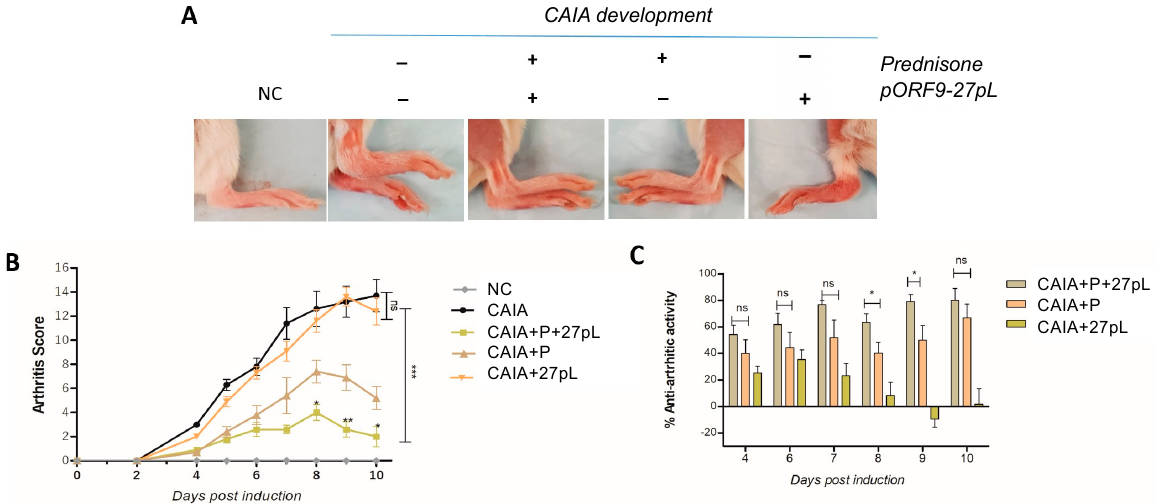
Figure 2. Modulation of arthritis severity by monotherapies or dual therapy of prednisone (P) and pORF9-IL27pL (27pL). ( A ) Morphological changes of digits, foot, and ankle edema in collagen antibody-induced arthritis (CAIA) mice with and without treatments and NC (no CAIA control). ( B ) Arthritis score showed an increase in the CAIA animals indicating the onset of RA. Treatment of the CAIA mice with P significantly reduced the arthritis score indicating a reduction in arthritis severity. Combination with pORF9-IL27pL (27pL) significantly improves P’s effect on day 8, 9, and 10 post-induction. 27pL treatment by itself was not able to prevent the onset of RA. ( C ) Anti-arthritic activity analysis showed efficacy for P monotherapy and P + 27pL combination on day 8 and 9. Results represent mean ± SEM. This figure is the combination of two independent experiments ( n = 11–12). A one-way analysis of variance (ANOVA) followed by Tukey’s multiple comparison t -test was used to calculate the statistical difference. The Mann–Whitney non-parametric test was used to calculate the statistical difference between P and P + 27pL (* p ≤ 0.05; ** p ≤ 0.01, *** p ≤ 0.001, with ns, not significant).